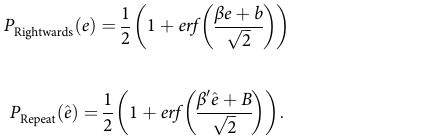
The sensitivities β and β ’ quanti fi ed the stimulus discrimination ability, while the fi xed side bias B captured the animal side preference for the left ( B <0) or right port ( B > 0), and the repeating bias b captured the animal ’ s tendency to repeat ( b > 0) or alternate ( b < 0) their previous choice. Within-subject error bars were estimated by one standard deviation of a nonparametric bootstrap ( n = 1000). Across-subject error bars, corresponded to the 1st and 3rd quartiles. Generalized linear model (GLM) analysis . We built a GLM where different features, such as the current stimulus and previous history events, were linearly summed to give rise to the probability that the rat ’ s response r t in trial t was